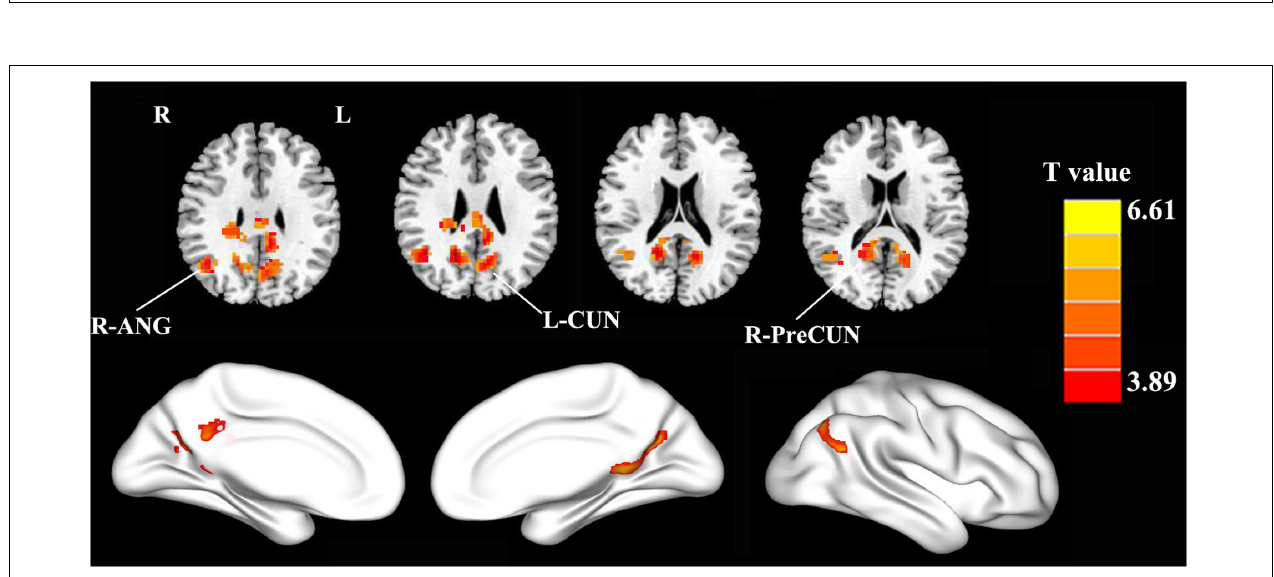
FIGURE 2 | Compared with the healthy controls, the patients with PD exhibited enhanced FC between the PCC and the right precuneus (R-PreCUN), left cuneus (L-CUN), and right angular gyrus (R-ANG) (two-tailed, voxel-level: p < 0.01, GRF correction, cluster-level: p < 0.05).